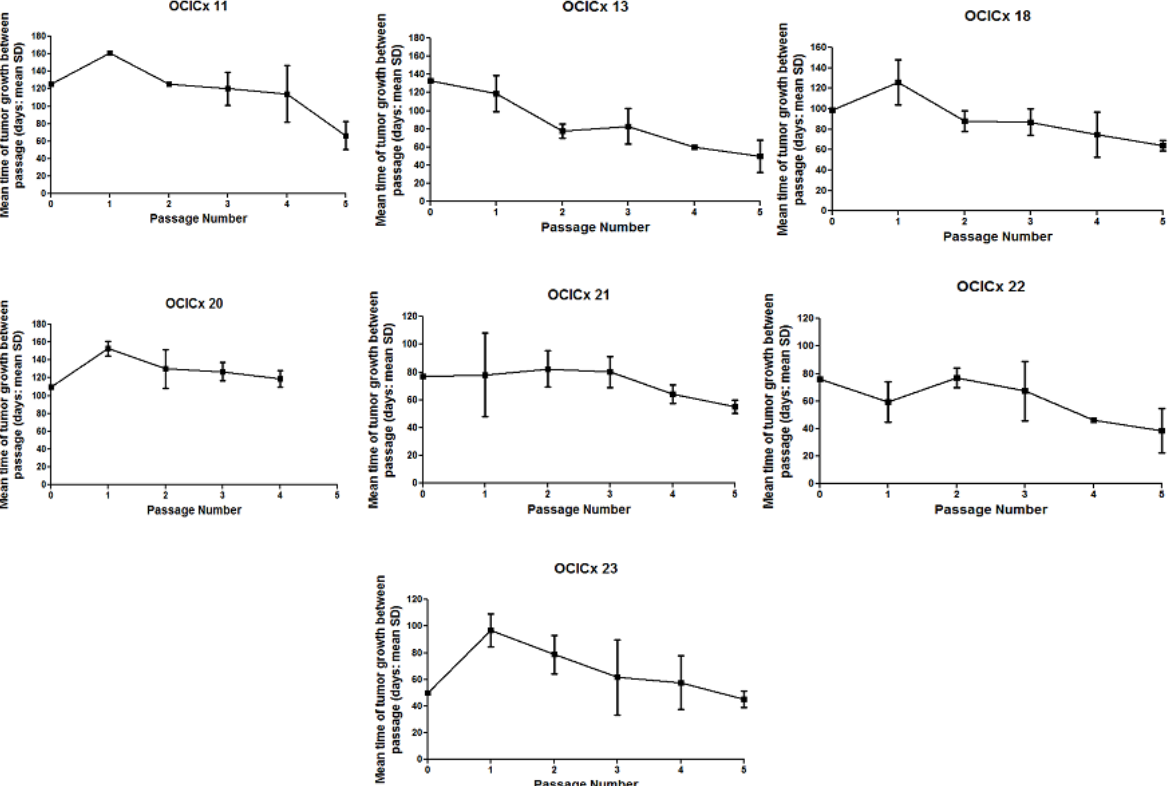
Supplementary Figure 1. Mean time for tumor growth between passages for the OCICx models (11, 13, 18, 20, 21, 22, 23). Time in days are plotted in passage number shown (mean ± SD) for xenografts in that passage. Passage number at 0 indicates